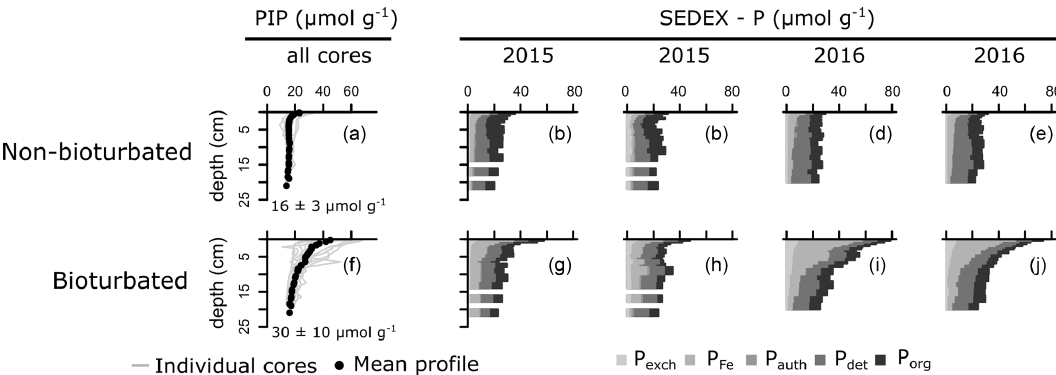
Figure 4. Vertical solid-phase profiles of non-bioturbated (a) and bioturbated (f) particulate inorganic phosphorus (PIP). Values are depth- averaged concentrations. (b–e, g–j) Solid-phase phosphorus speciation (SEDEX) of cores collected in 2015 and 2016. P exch : exchangeable phosphorus, P Fe : iron-bound phosphorus, P auth : authigenic phosphorus, P det : detrital phosphorus, P org : organic phosphorus. Note that the P auth fraction is too small to be visible in the